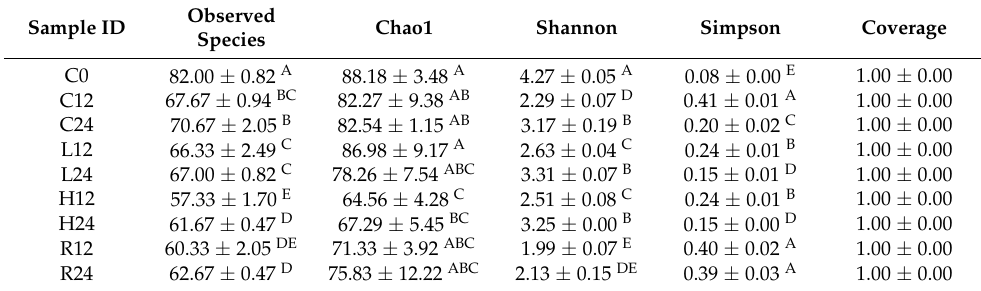
Table 2. Alpha diversity estimation of fecal microbiota during